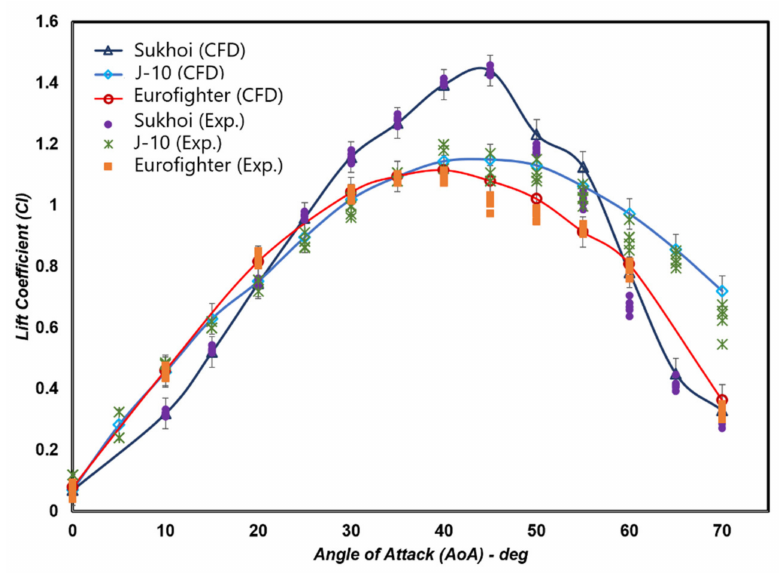
Figure 4. The lift coefficient (Cl) vs. angle of attack (AoA) ( α ) for each aircraft